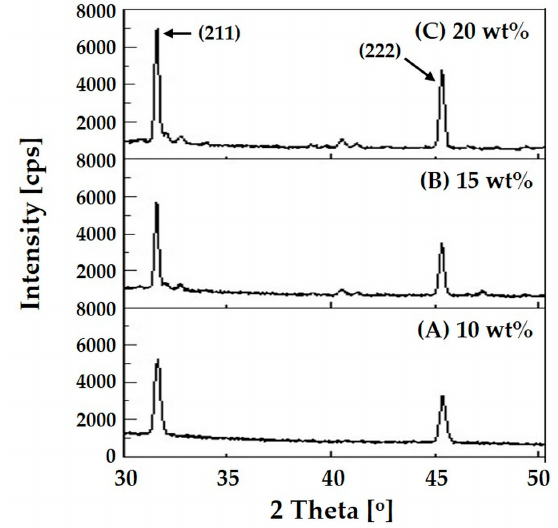
Figure 7. Representative XRD patterns of nanofibrous collagen/HA composite microsphere synthesized with different levels of HA: ( A ) 10 wt %; ( B ) 15 wt %; ( C ) 20 wt %, after 3 days of immersion on the SBF solution.